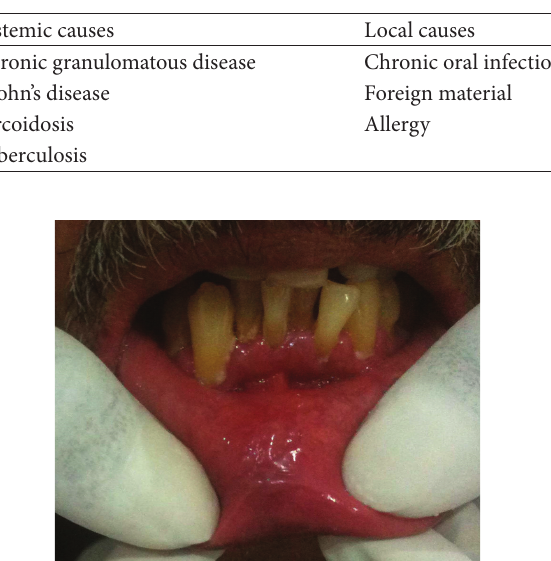
Figure 1: Diffuse swelling of lower lip.